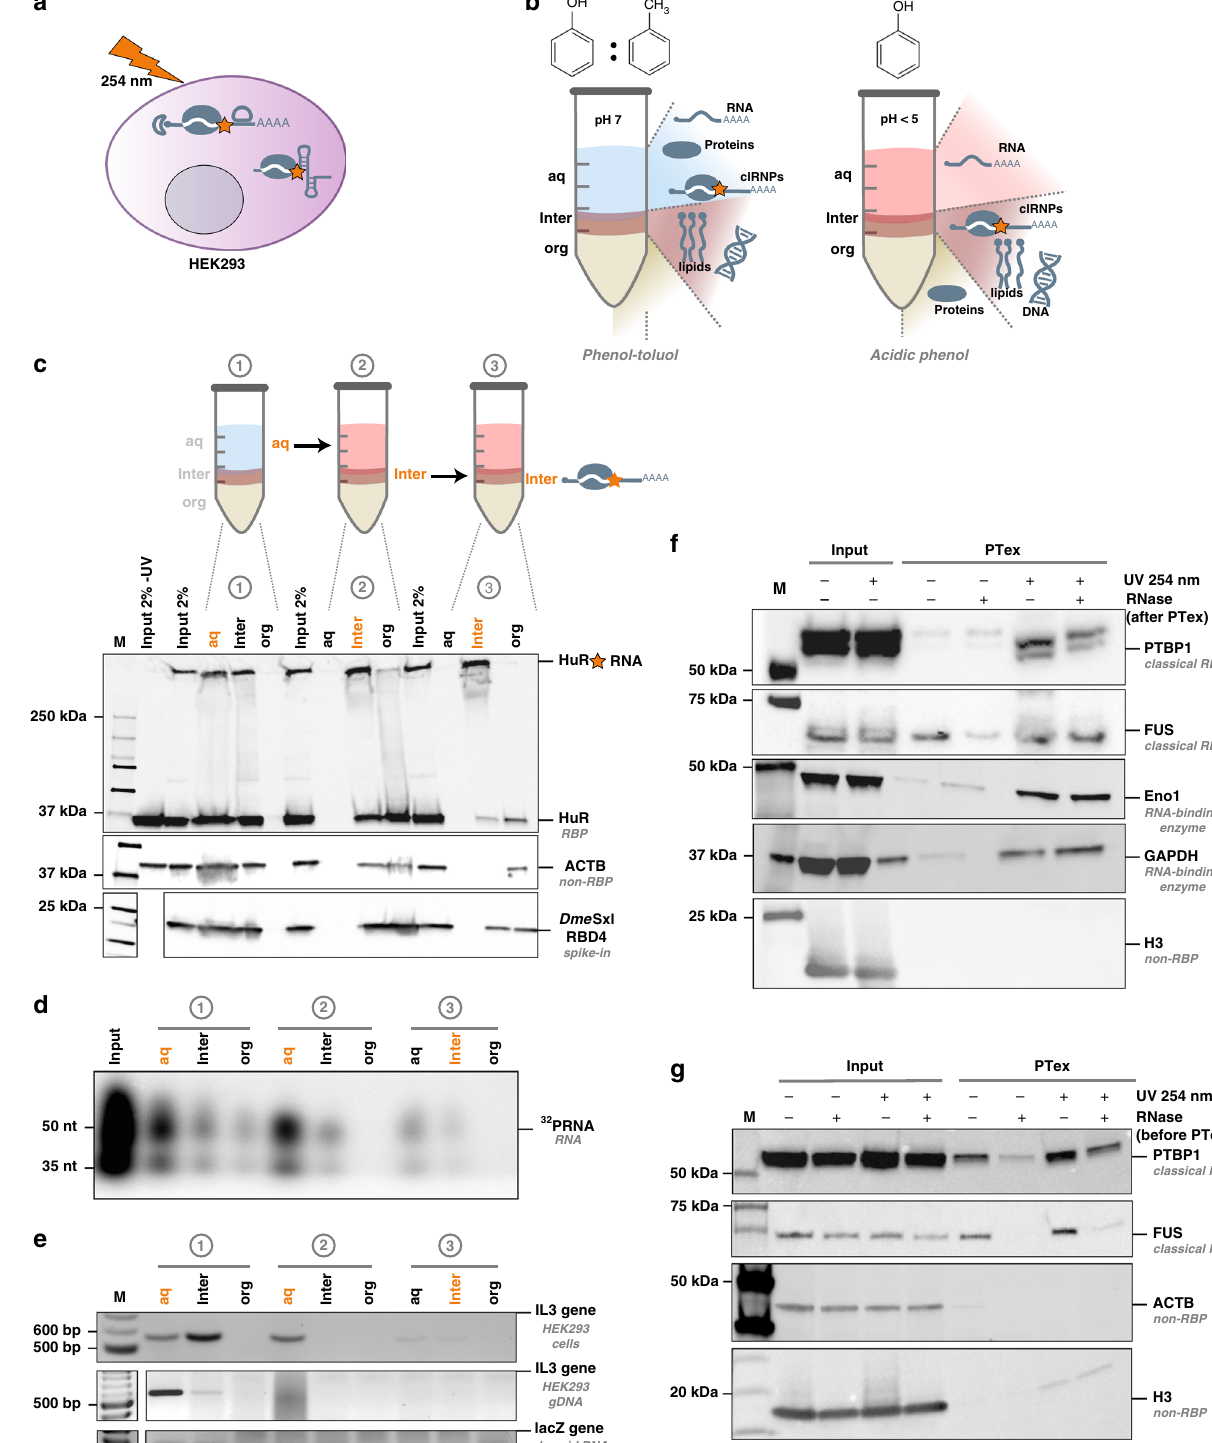
191 nucleotides, all of which contained the same Sxl-binding motif at their 5 ′ -end. After binding and UV cross-linking in vitro, samples were PTex-puri fi ed and analysed by western blotting (Fig. 2c). PTex ef fi ciently recovered cross-linked Sxl-RBD4 complexes with RNA as short as 30 nt. Similar to HuR, we cal- culated the recovery of Sxl by densitometry (Fig. 2d) which is ∼ 50% of the input cross-linked protein. Since puri fi cation